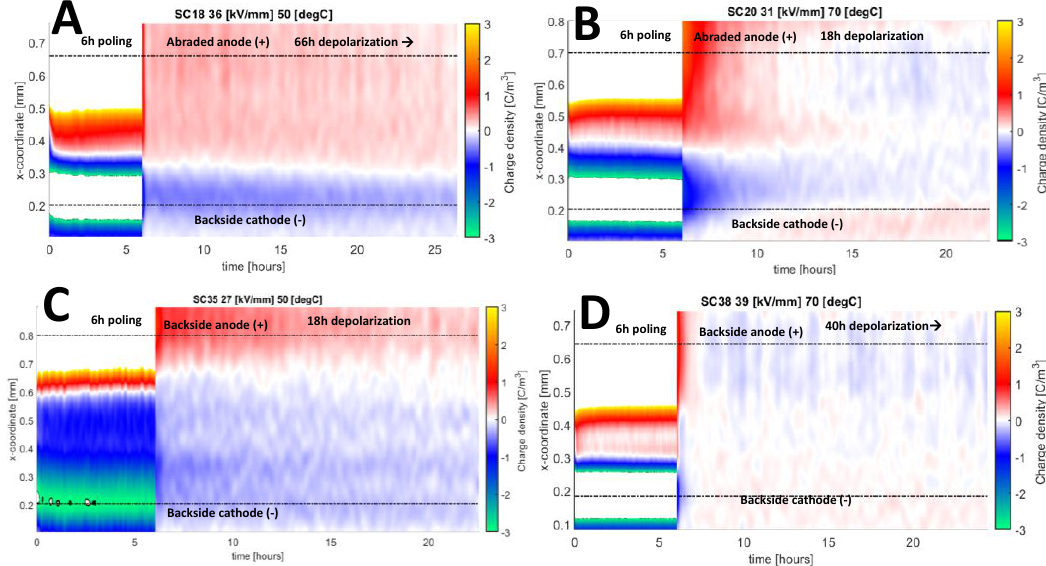
Figure 10. PEA measurements performed at 50 °C (left, A and C ) and 70 °C (right, B and D ) with +15 kV of poling voltage. Top figures show measurements with abraded anode while bottom surfaces show measurements with a backside anode.